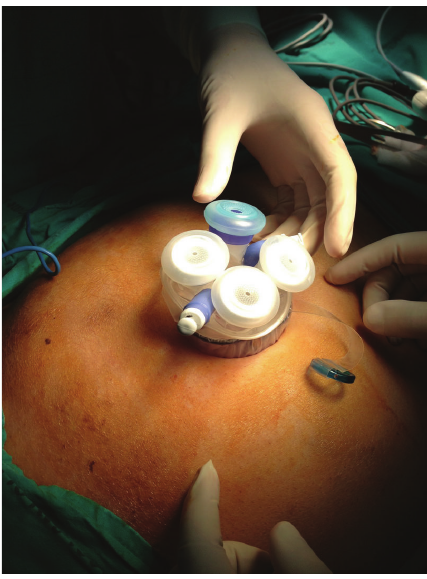
Figure 1: Port position.